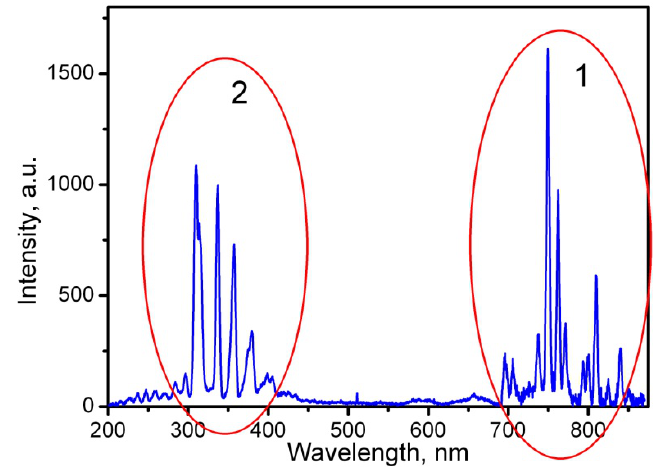
Figure 6. The emission spectrum of the discharge plasma in argon upon excitation by microwave radiation with ν = 2.45 GHz. 1—group of lines of neutral Ar atoms; 2—lines of nitrogen molecules and OH groups.